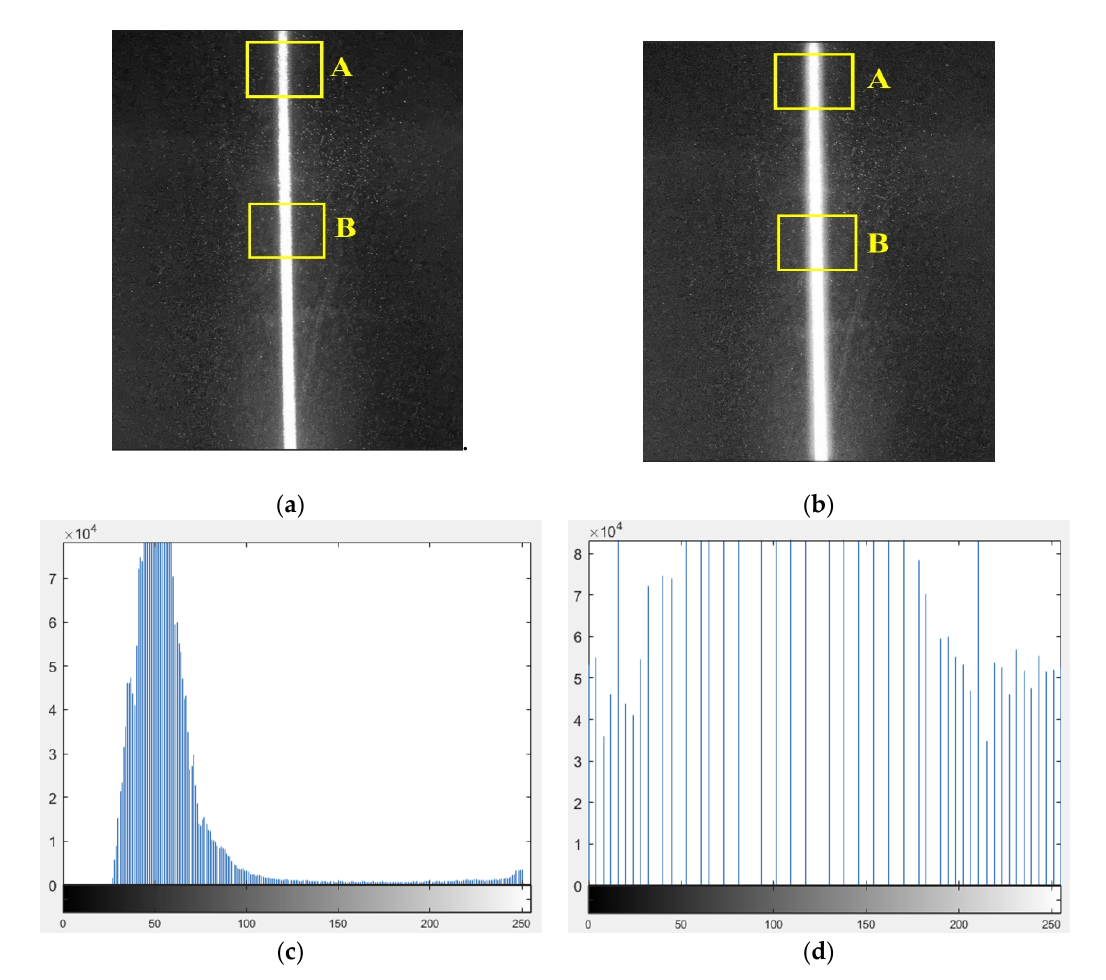
Figure 6. Light intensity averaging results of light stripe image. ( b ) Original image. ( b ) Light intensity averaging image. ( c ) Gray histogram of original image. ( d ) Gray histogram of light intensity averaging image.